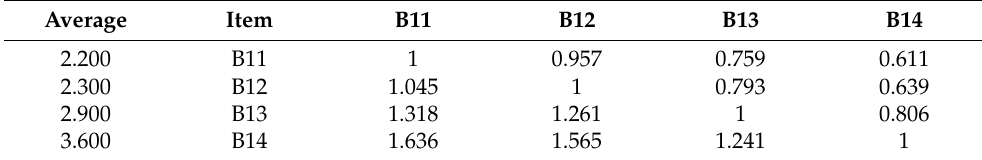
Table 3. AHP layer analysis judgment matrix.